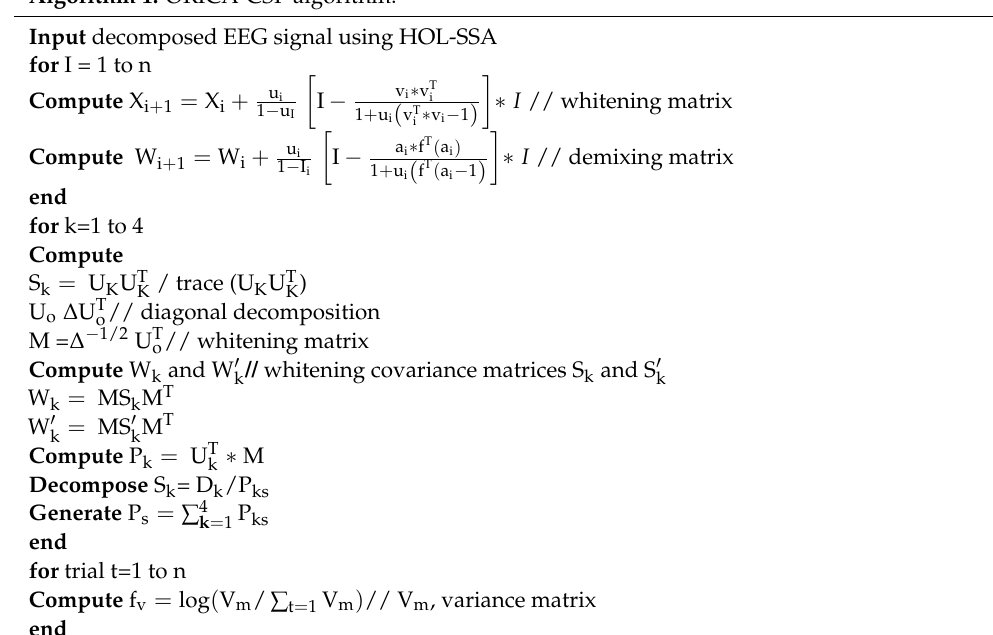
Algorithm 1: ORICA-CSP